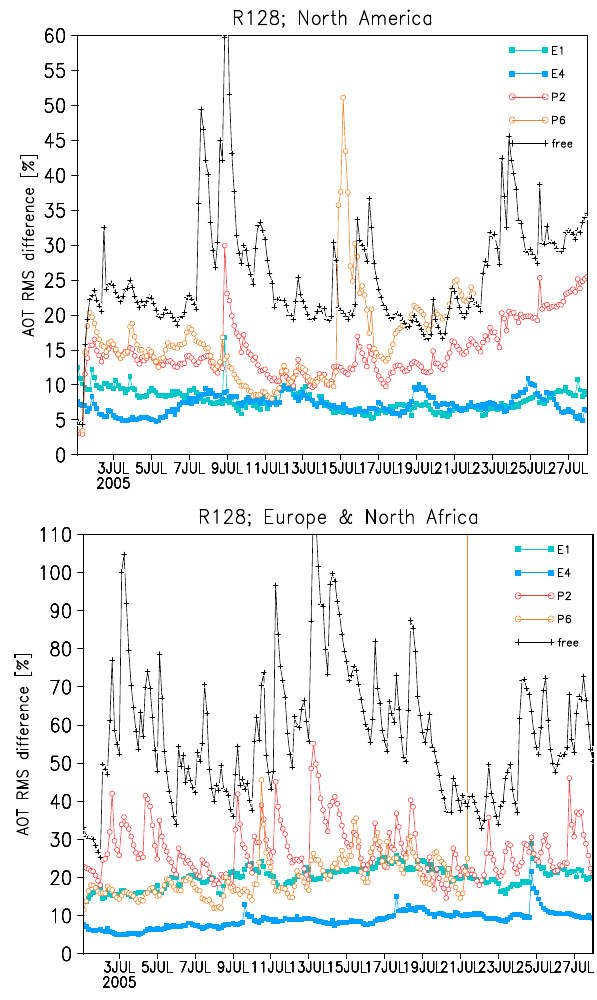
Fig. 2. Area-averaged differences [%] in AOT, for n reg = 128 experiments. The R128E2P4 experiment is used as the reference. The coloured lines refer to experiments for various ensemble sizes (E) and patch sizes (P). Notice how the assimilation converges as ensemble size increases. Also notice this is not the case for patch size, which has overall a bigger effect on the results.